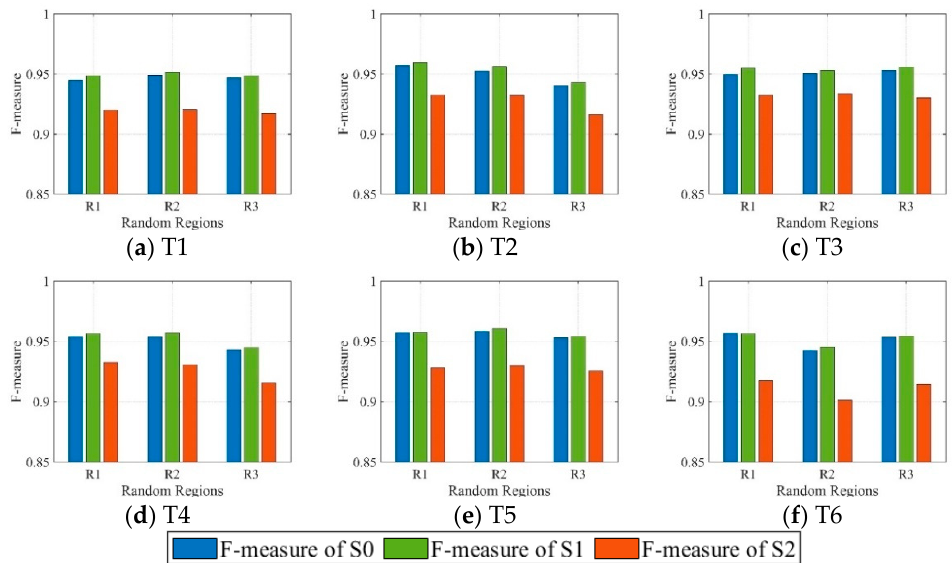
Figure 6. Accuracy assessment of three comparison strategies for random regions with the tile size 1000 and step 50.